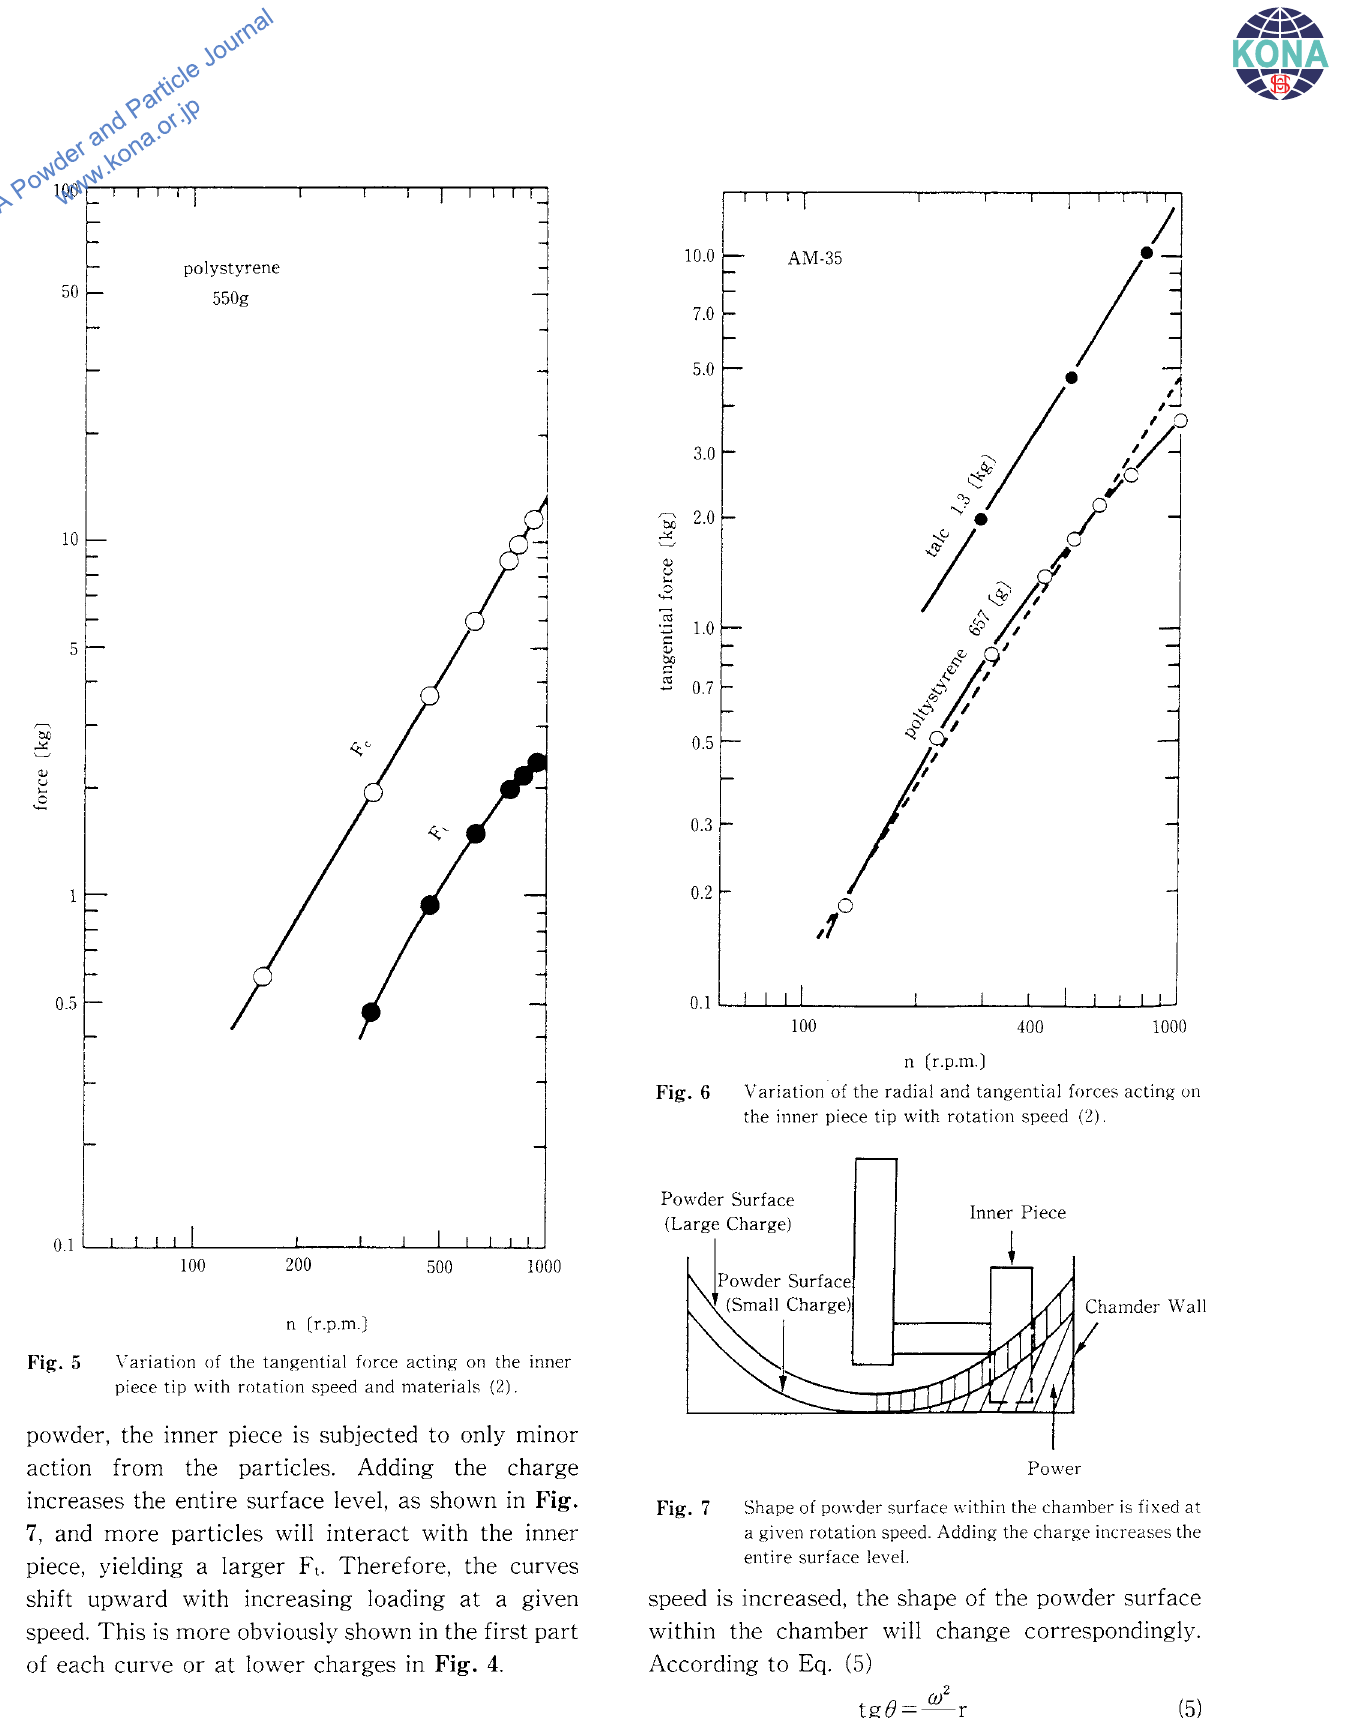
Powder Surface (Large Charge)